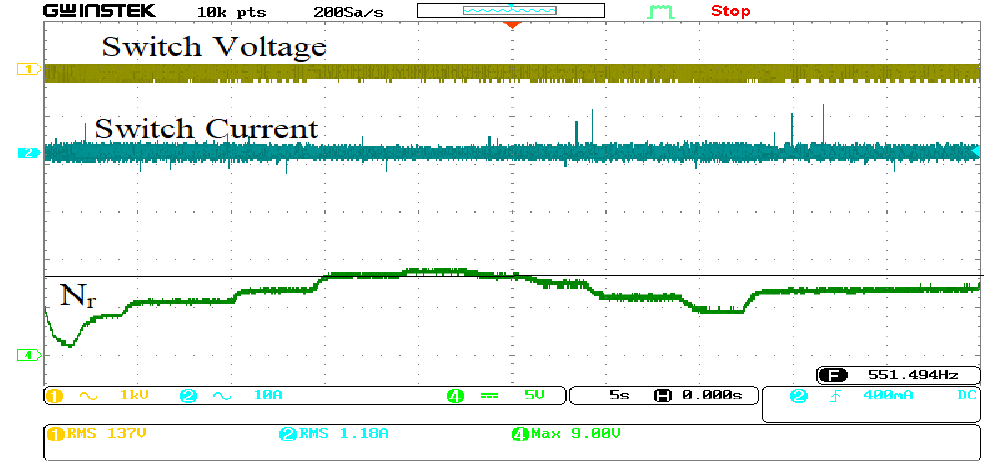
Figure 21. Voltage across switch and current flowing through the switch during variable speed op-